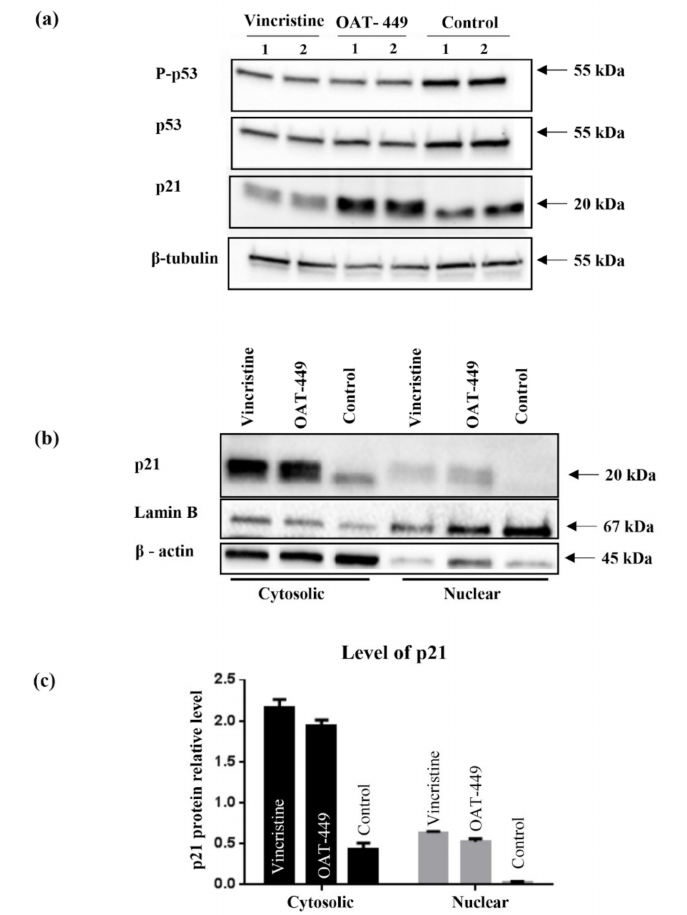
Figure 9. Correlation of p21 and p53 proteins expression level and their distribution between cytosolic and nuclear fractions after treatment with 30 nM OAT-449 or vincristine. ( a ) Immunoblot of p53 / P-p53 (Ser15) and p21 proteins using whole cell lysate of HT-29 cells in basal condition and upon treatment with 30 nM OAT-449 or vincristine. (Lanes 1–2 represent biological replicates for each experimental condition). ( b ) Immunoblot of p21 protein in the cytoplasmic and nuclear fraction of HT-29 cells in basal condition and after 18 h treatment with 30 nM OAT-449 or vincristine. Lamin B and β -actin were used as a loading control for nuclear and cytoplasmic proteins. ( c ) Graph represents summary of densitometry of at least 3 independent western blot analyses (mean ±